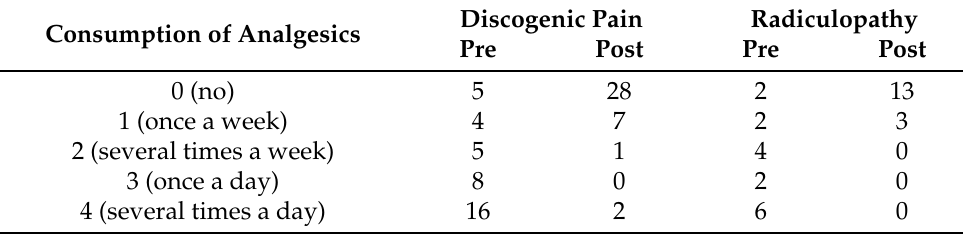
Table 3. Anaglesic consumption in RLP and DP groups before and 6 months after